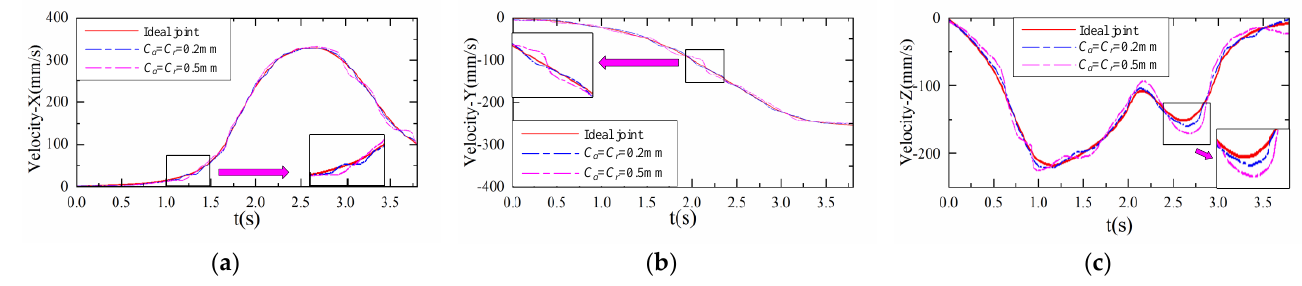
Figure 10. Velocity curve of the end effector along the X , Y , and Z axes. ( a ) The velocity curve along the X −axis in the frame O − XYZ ; ( b ) the velocity curve along the Y −axis in the frame O − XYZ ; and ( c ) the velocity curve along the Z −axis in the frame O − XYZ .